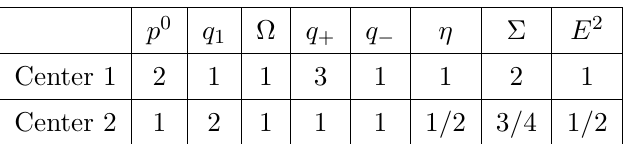
Table 1 . Charges and other quantities of the 2-center dyonic solution of the ST[2 ; 6] model. We have set the YM coupling constant g = 1. For this solution (cid:6) 12 = (cid:10) 12 = 3, E 2 E 12 (cid:0) E 1 (cid:0) E 2 (cid:24) 0 : 9 >